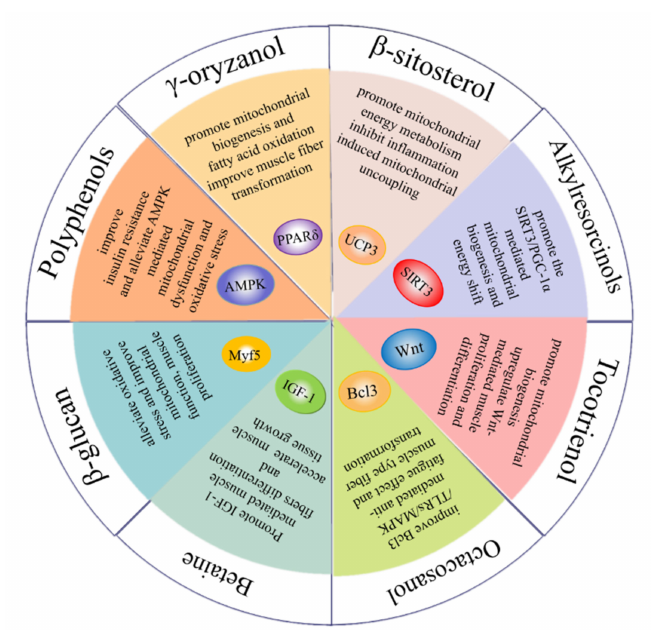
Figure 2. Bioactive components of whole grains for improving skeletal muscle